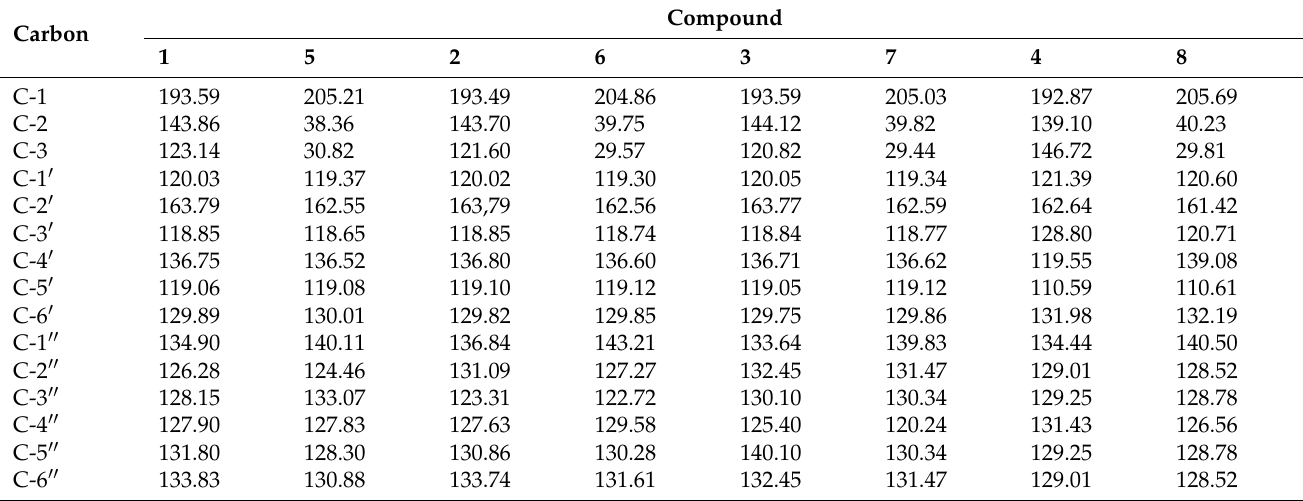
Table 4. Summary of signals visible in the 13 C NMR spectrum of the substrates and the biotransfor- mation products.